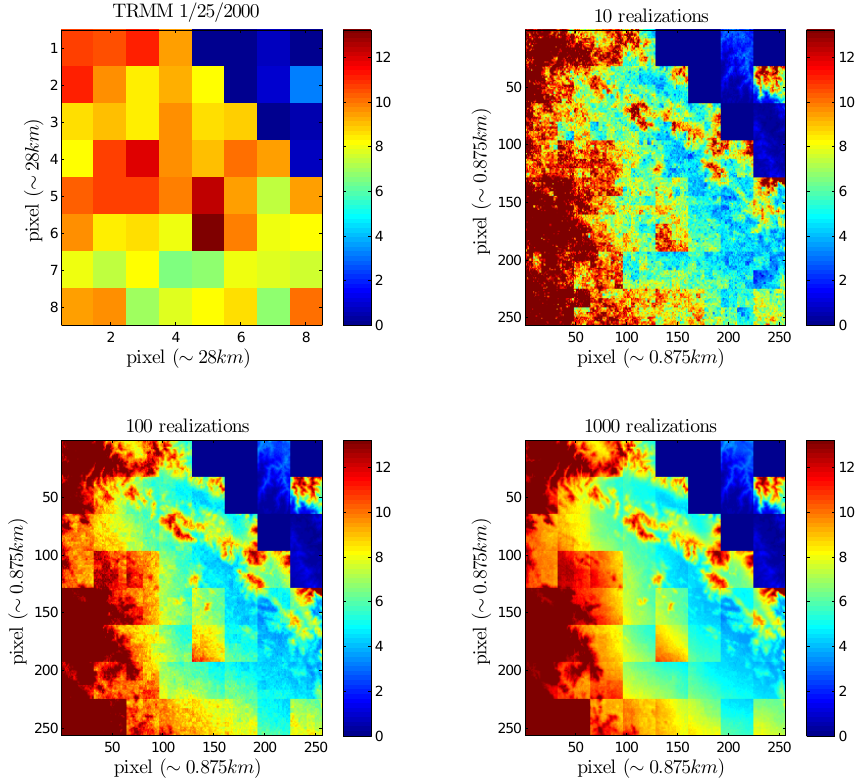
Figure 12. Ensemble test for the downscaling and correction of TRMM information for 25 January